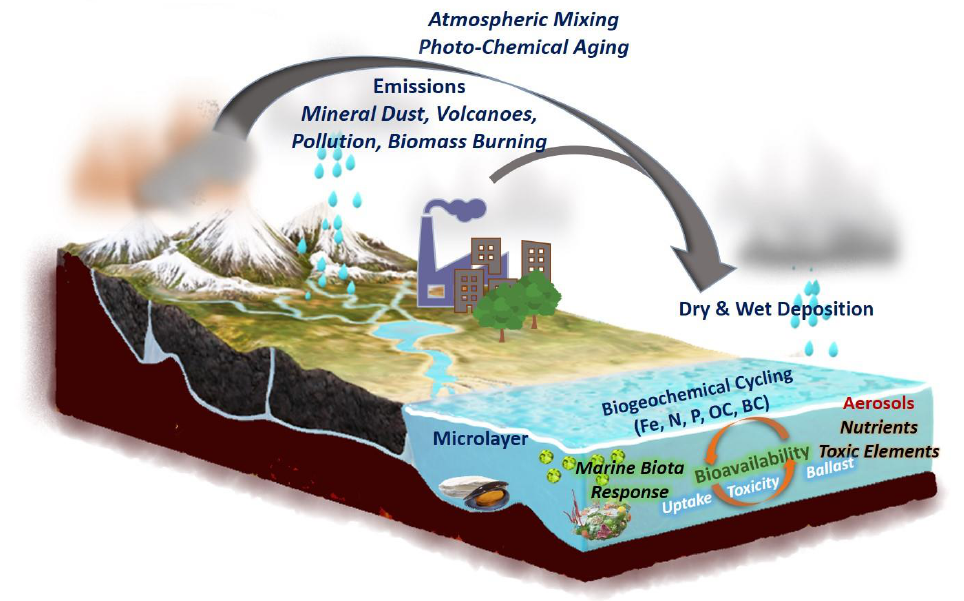
Figure 1. Conceptual diagram illustrating the aerosols sources (natural and anthropogenic), transport, and deposition onto marine ecosystems, inducing biotic responses. Upon deposition onto the upper ocean, aerosols can impact nutrient and toxic elements availability, ocean biogeochemistry, ocean productivity, and carbon cycling. The description of these topics can be seen in the relevant